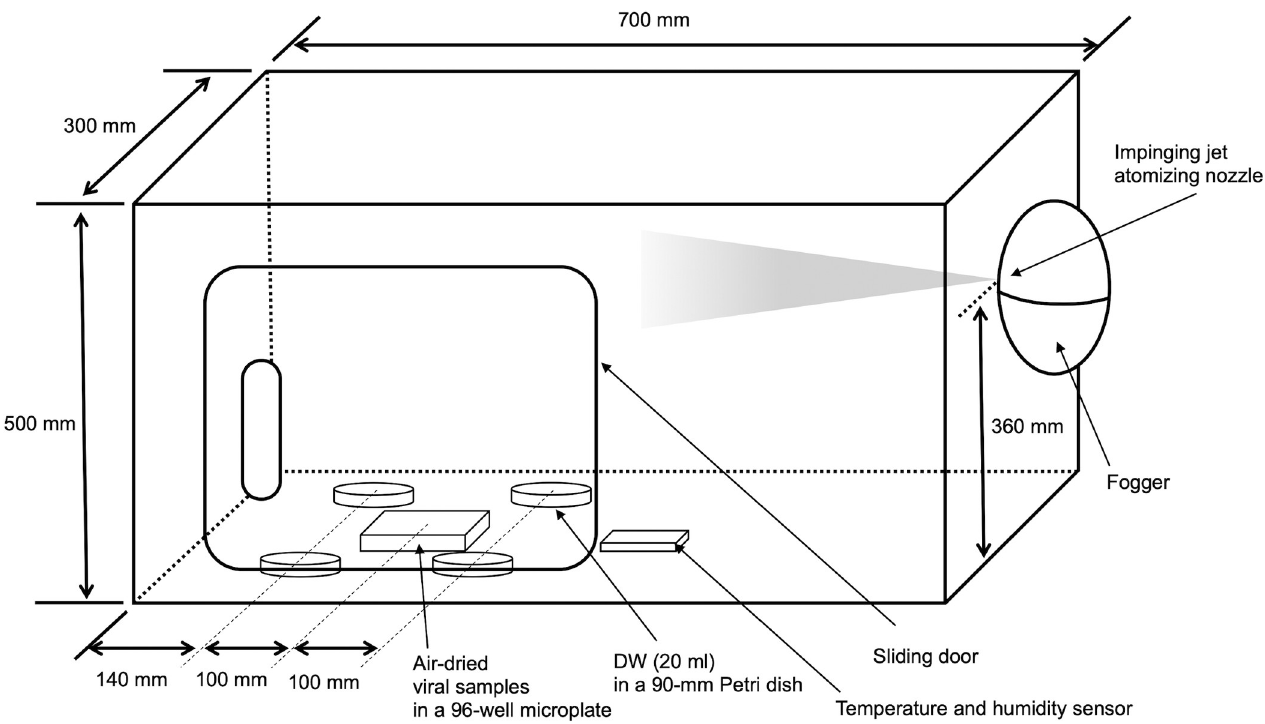
Fig 1. Schematic illustration of the test chamber. The composition of the chamber is described in detail in the Materials and methods.